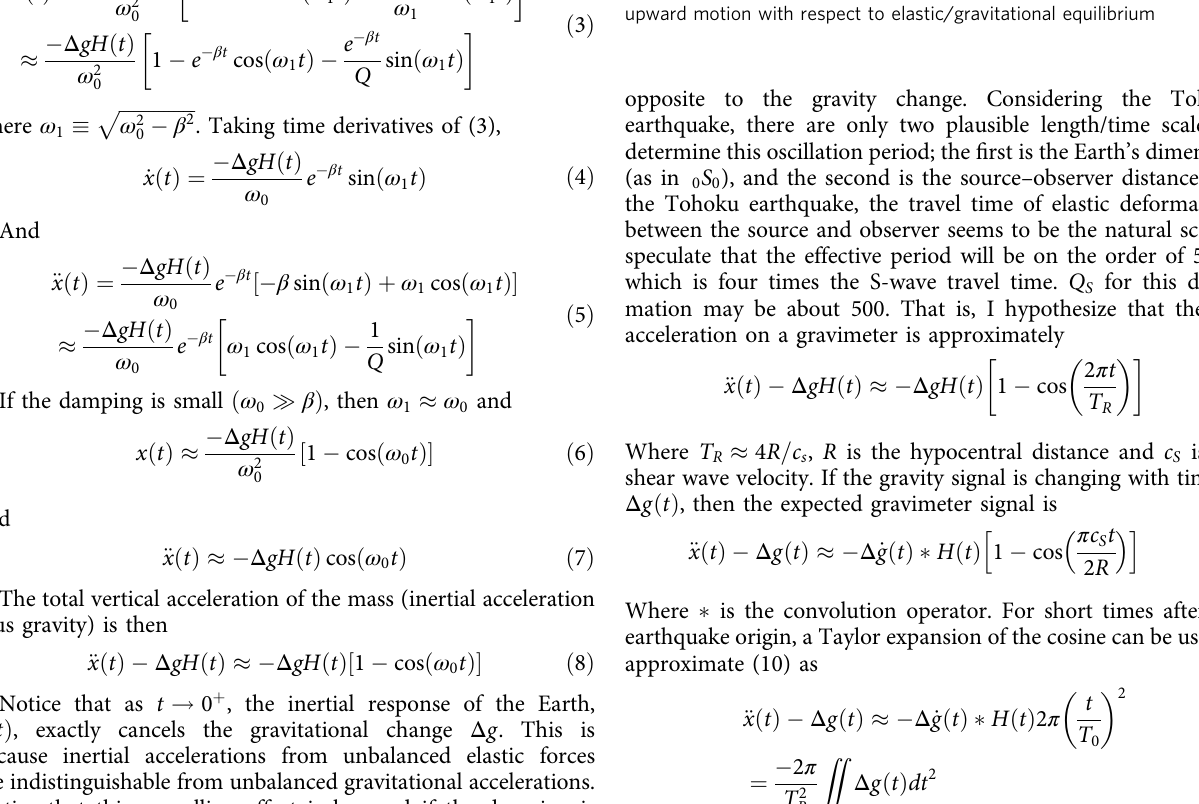
Fig. 1 Schematic showing the parameters used to describe the acceleration of an elastically supported mass in the presence of a downward gravitational acceleration with an instantaneous step of Δ g . x is upward motion with respect to elastic/gravitational